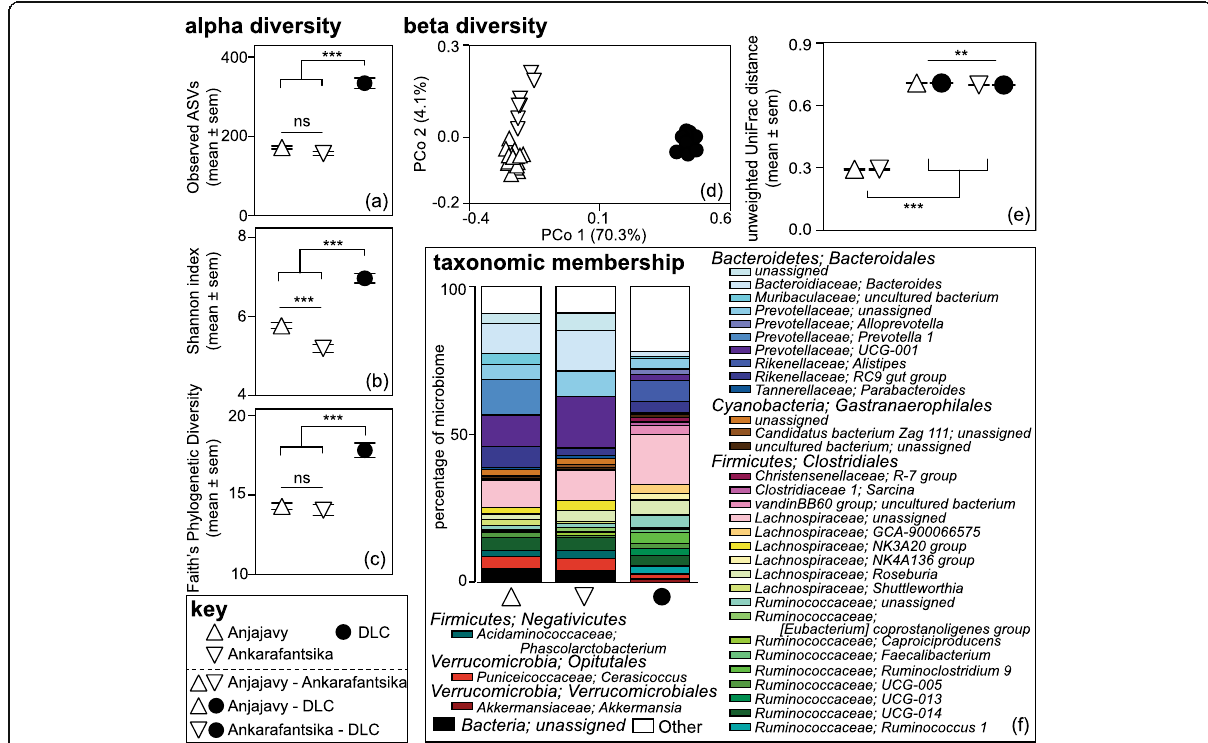
Fig. 2 Gut microbiome structure in Coquerel ’ s sifakas ( Propithecus coquereli ), including wild populations living in the Anjajavy Protected Area (up triangle) and Ankarafantsika National Park (down triangle), and the captive population at the Duke Lemur Center (DLC, black circle). Depicted are results of alpha diversity, including: a Observed ASVs, b the Shannon index, and c Faith ’ s Phylogenetic Diversity; beta diversity, including unweighted UniFrac distances graphed in d Principal Coordinate (PCo) space and as e pairwise comparisons, and; f taxonomic membership, graphed as stacked bar charts of all the microbial genera that accounted for > 1% of the total microbiome, for which color families reflect microbial phyla and orders, and distinct shades reflect distinct species. “ Other ’ refers to the summation of all taxa that failed to reach 1% of the total microbiome. ** p < 0.01; *** p < 0.001; ns p >